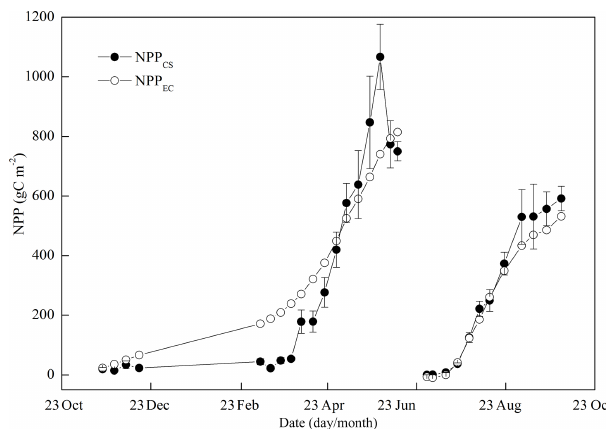
Figure 12. Seasonal variations in the cumulative net primary pro- ductivity (NPP) with two independent methods of crop sampling (NPP CS ) and eddy covariance (NPP EC ) complemented with soil respiration